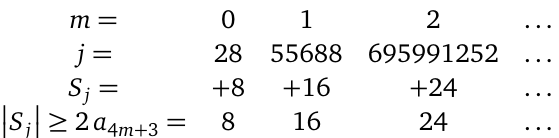
Figure 3: Counter S instances. In addition, we show S with the lower bound (51). Blue, green, and orange dots correspond to m = 0, 1, 2,